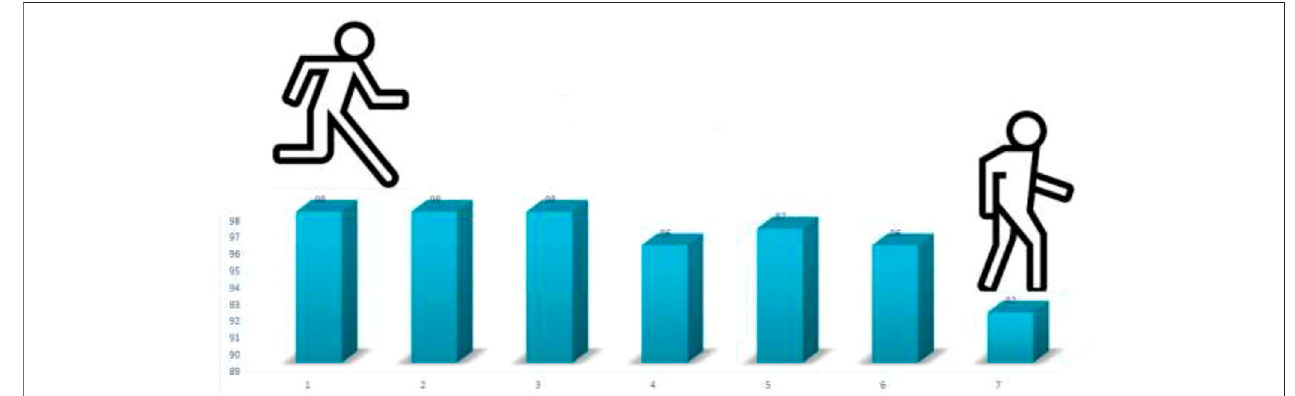
FIGURE 6 | The recyclability of